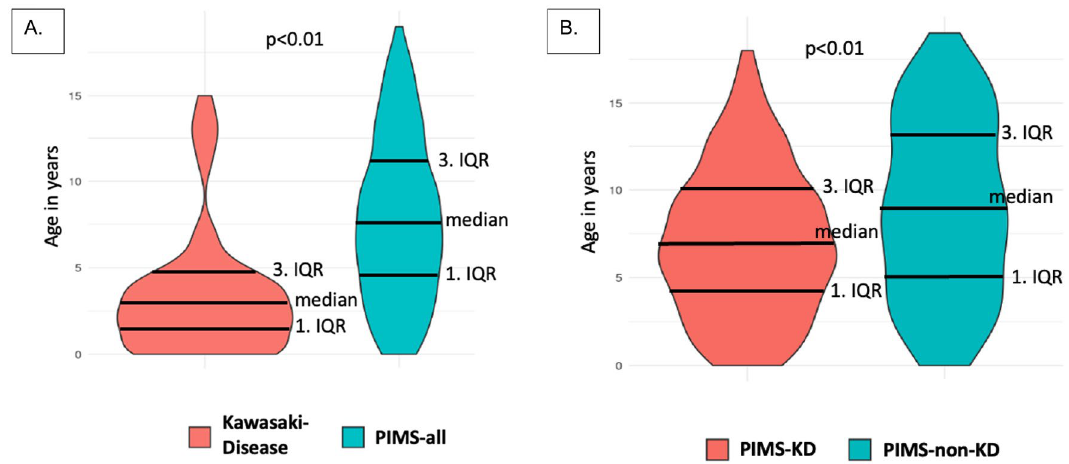
Figure 2. Age distribution of patients with ( A ) PIMS-all and KD, as well as of patients with ( B ) PIMS-non-KD and